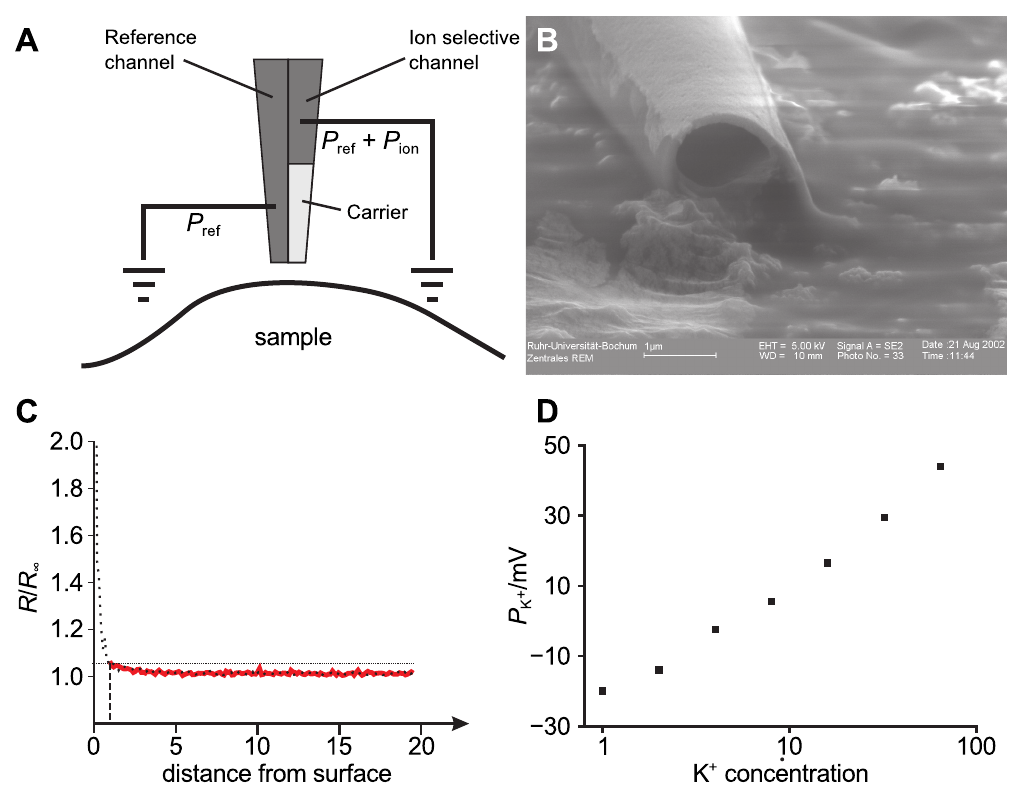
Figure 11. ( A ) Sketch of a double barrel ion selective micro-electrode (ISME). One channel is used as the reference channel and for SICM recording, the tip of the second one is filled with an ion selective liquid membrane, the bulk filled with 100 mM KCl; ( B ) Scanning electron micrographs of a double barrel electrode. Each channel has an opening diameter of approximately 1 µ m; ( C ) Approach curve of an ISME towards the cell culture dish. The threshold of 5 % (solid black line) is determined at approximately 1 µ m tip-sample distance (dashed line); ( D ) The potential across the liquid membrane follows Nernst’s